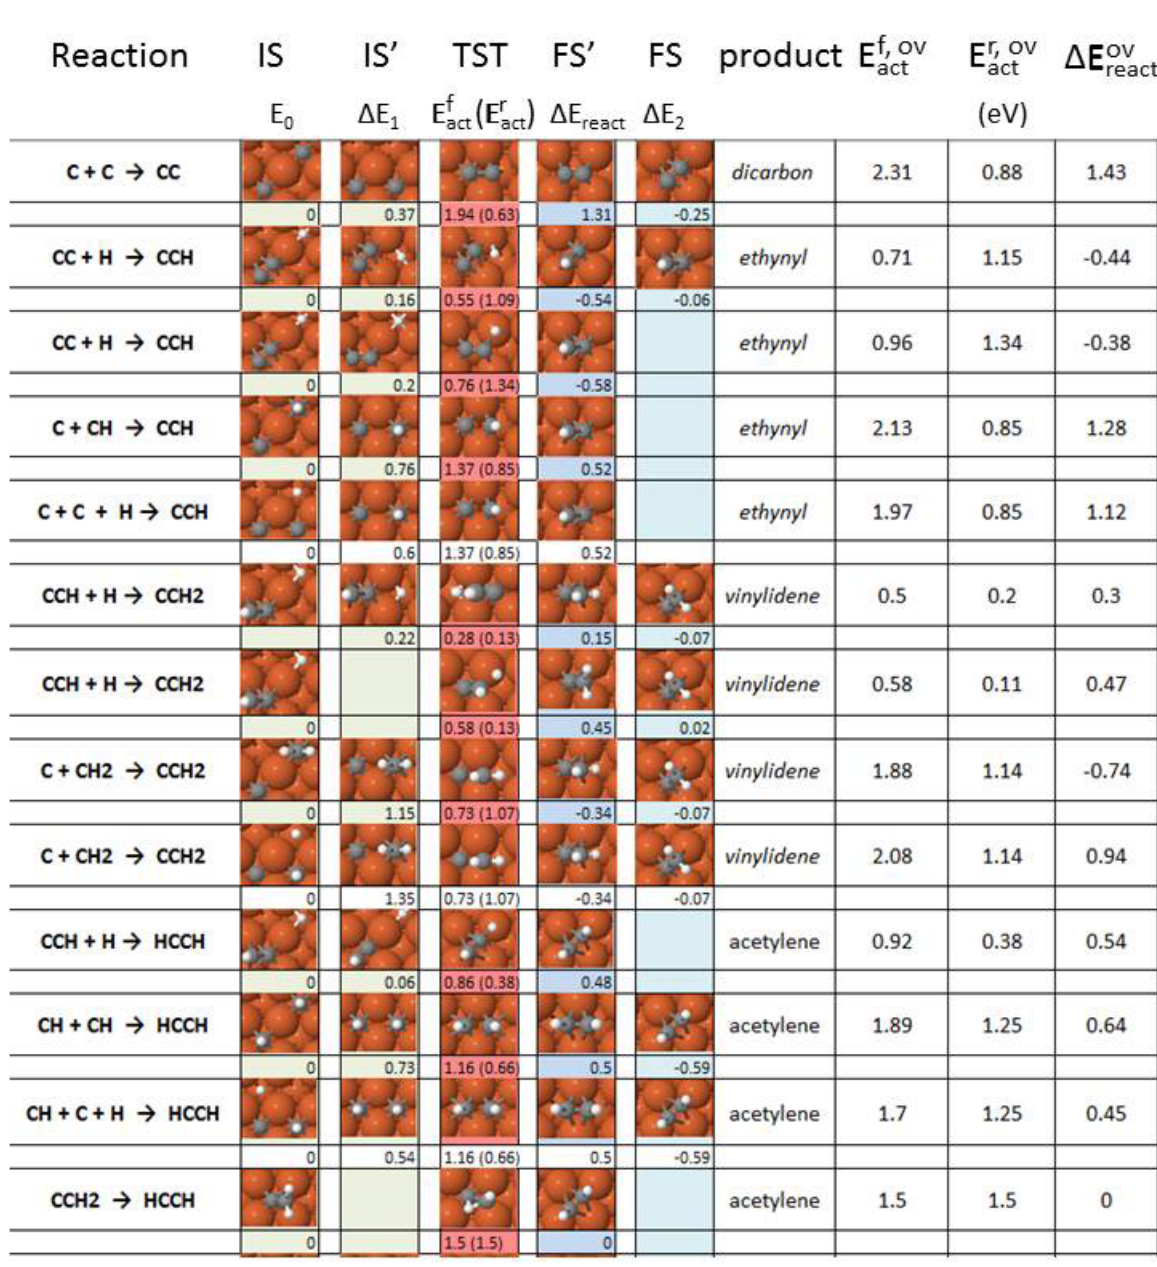
Table 2. Elementary steps for C steps, and ( b ) ethylene and ethane formation steps, along with energy parameters as defined in Figure